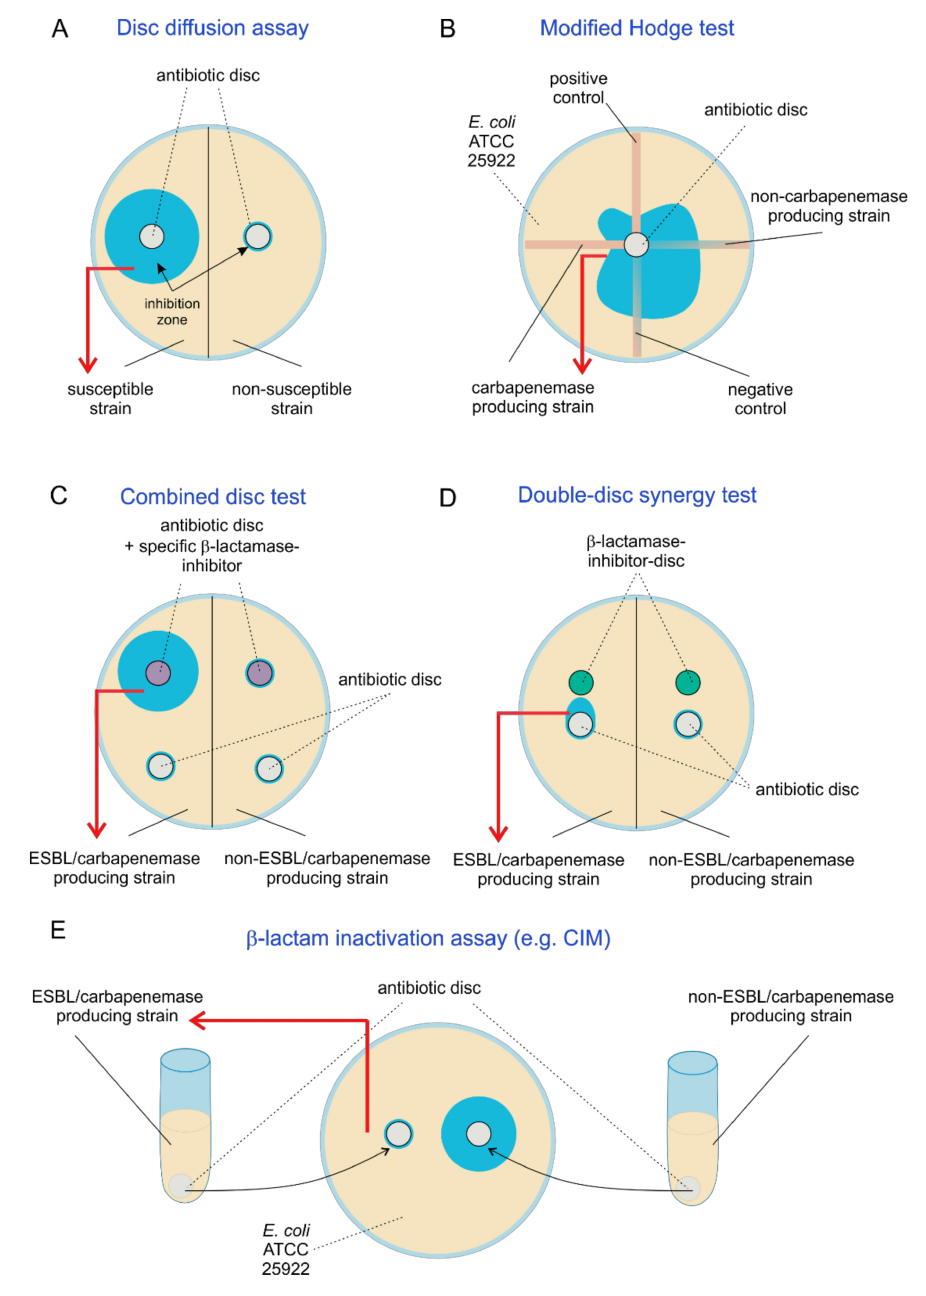
Figure 2. ESBL and carbapenemase detection by disc diffusion tests. Schematic overview of disc diffusion assay variations for detection of ESBL and carbapenemase-producing strains. ( A ) Principle of susceptibility testing by disc diffusion assay. ( B ) Modified Hodge test. ( C ) Combined disc test. ( D ) Double-disc synergy test. ( E ) β -lactam inactivation assay (e.g.,